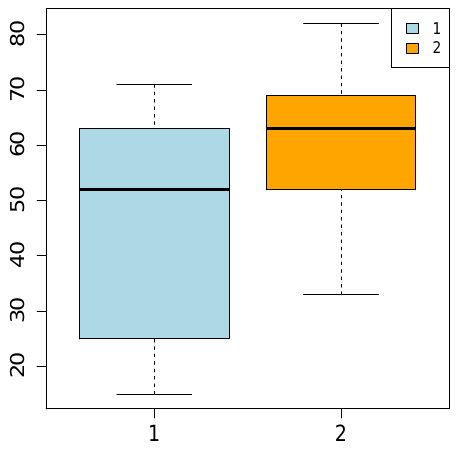
Figure 1. Boxplot of the variable “urban population” in clusters 1 and